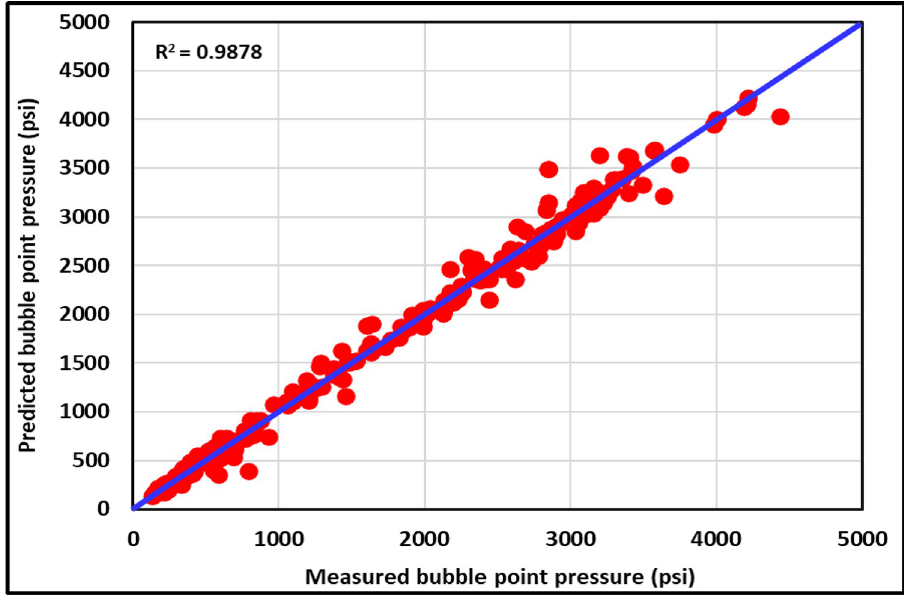
Fig 14. Cross-plot of testing ANFIS